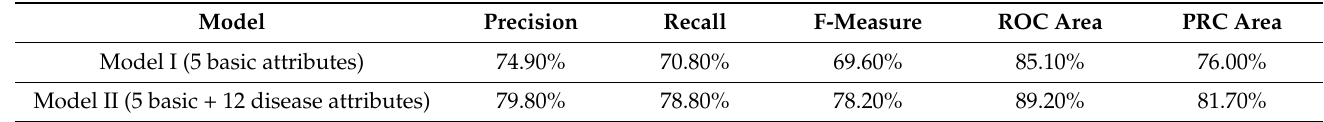
Table 6. C4.5 algorithm performance comparison for Model I and Model